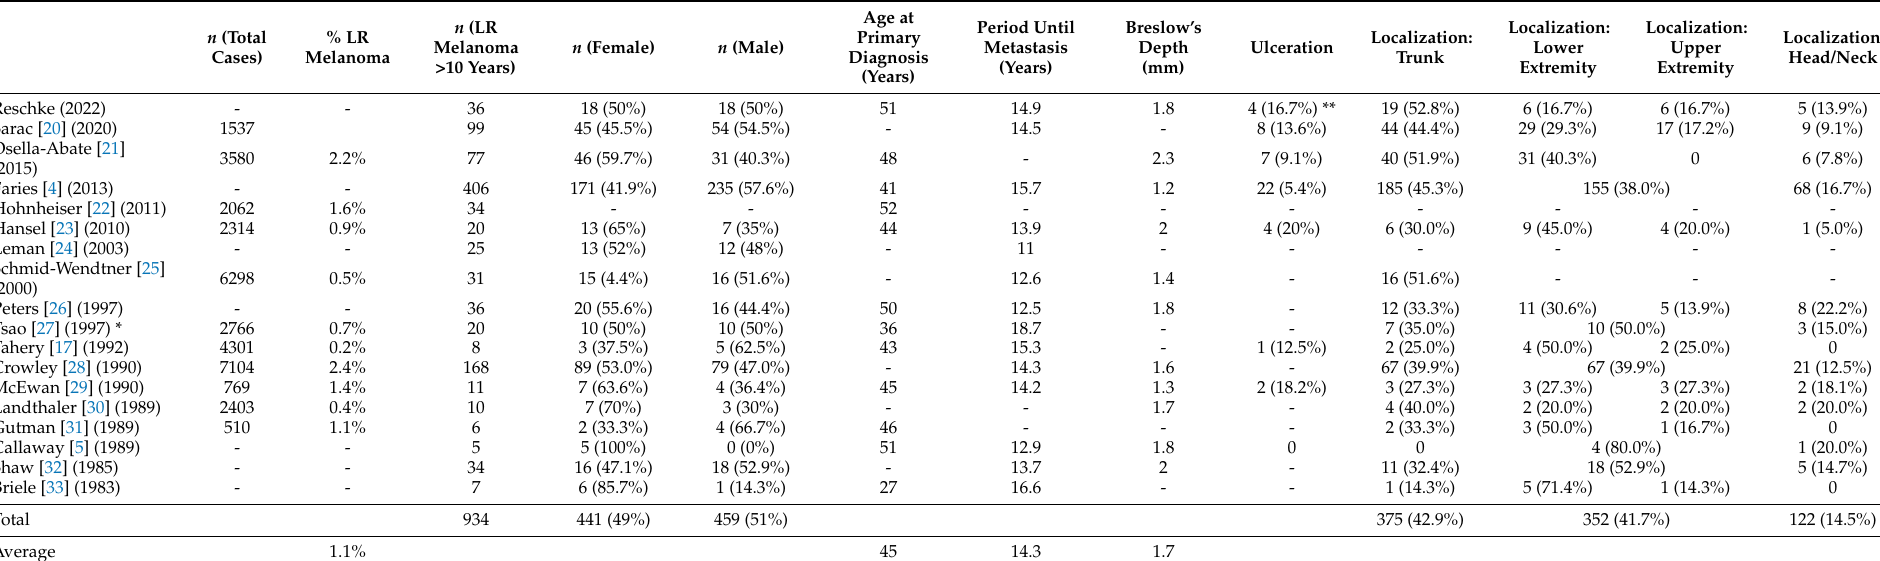
Table 6. Comparison of our study collective with cohorts of late recurrence melanoma from 17 publications. * Tsao et al. (1997) investigated only ultra-late recurrence of melanoma (metastatic disease > 15 years after primary diagnosis) ** Percentage refers to the cases with histopathological record ( n = 24). LR = late